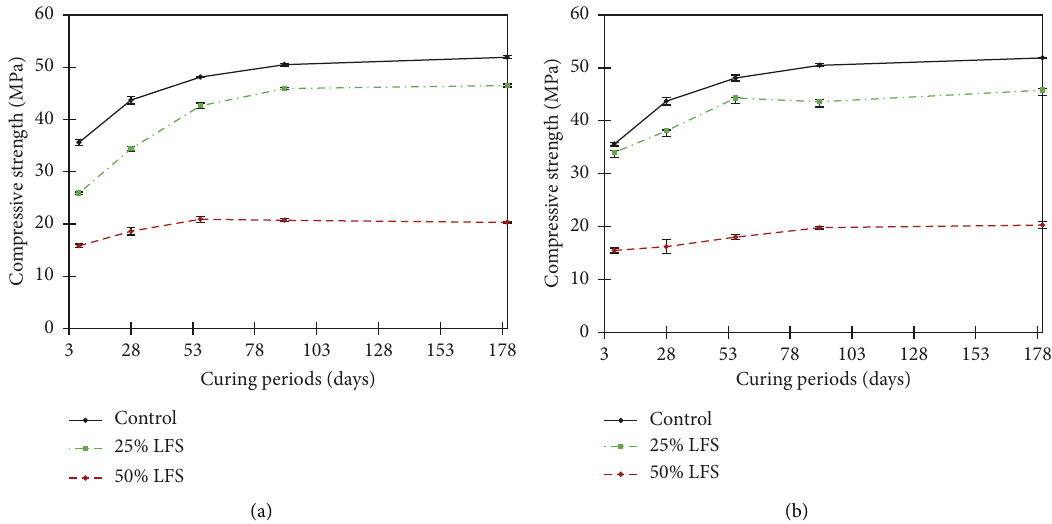
Figure 11: Relationship between compressive strength of mortar and curing period: (a) mortars with raw LFS; (b) mortars with sieved LFS.